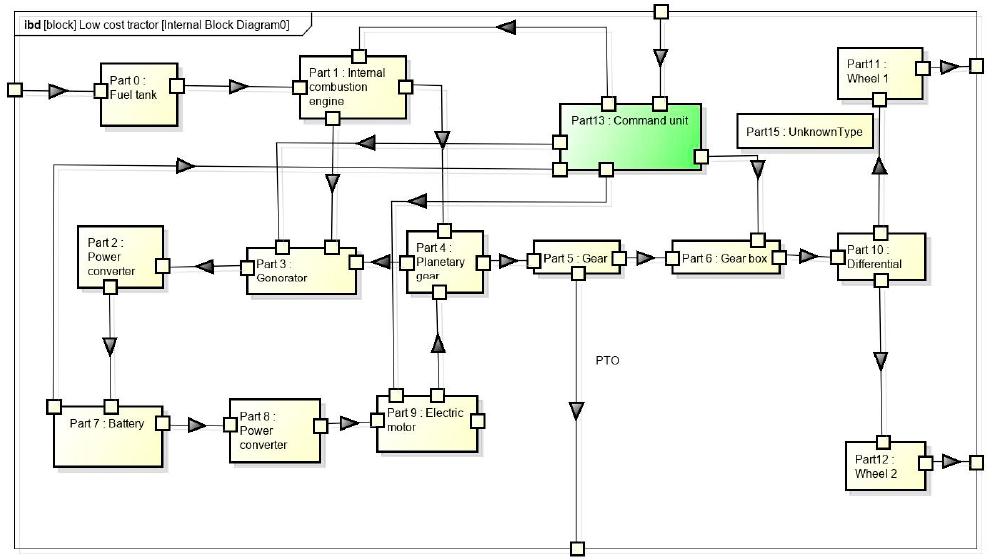
Figure 1. Principle of parallel architecture.